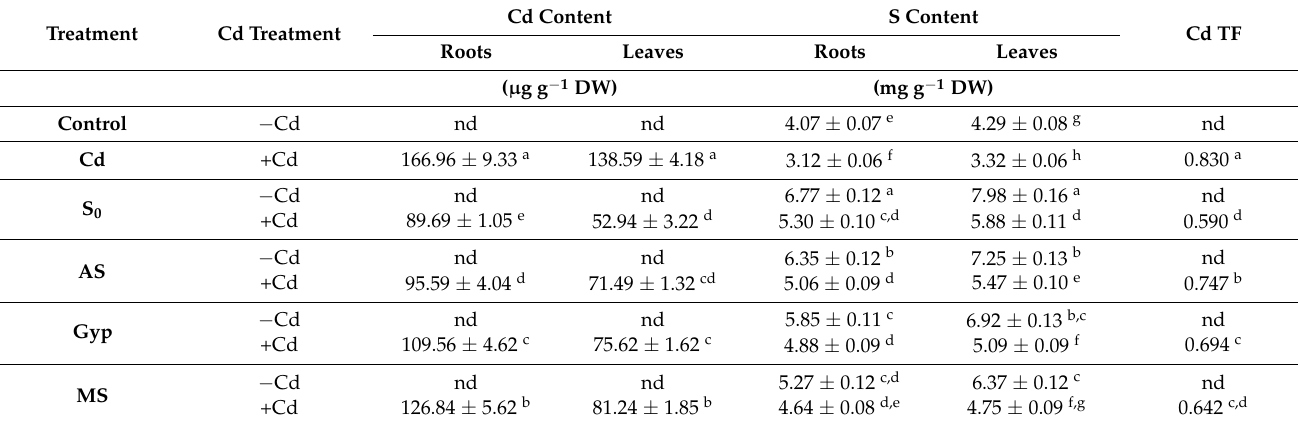
Table 4. Effect of 200 mg S kg − 1 soil of elemental S (S 0 ), ammonium sulfate (AS), gypsum (Gyp) and magnesium sulfate (MS) on Cd content and S content in Brassica juncea cv. Giriraj under Cd stress (200 mg Cd kg − 1 soil). Data are presented as means ± SE ( n = 4). Data followed by same letter within columns are not significantly different by LSD test at p < 0.05. − Cd, without cadmium; +Cd, with cadmium; DW, dry weight; nd, not detected; S, sulfur; TF, translocation